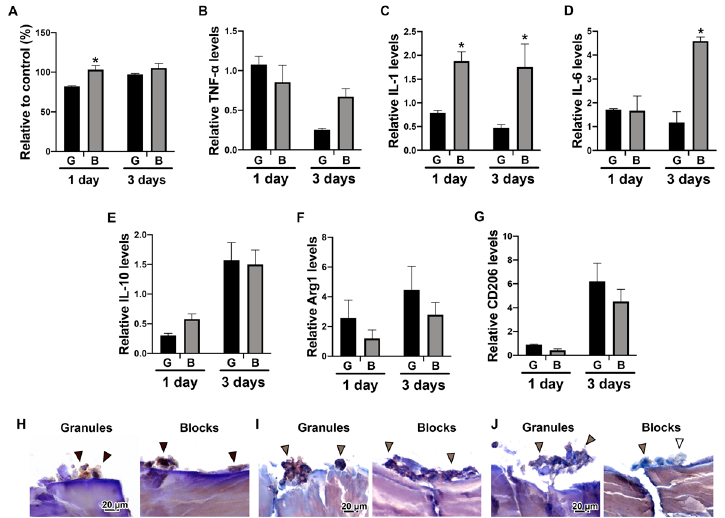
Figure 3. Macrophage polarization potential on DBBM granules or blocks. ( A ) Viability assay of THP-1-derived M ϕ s cultured on DBBM granules (shown as “G”) or blocks (shown as “B”) on days 1 and 3. (* Denotes significantly higher than the other group, p < 0.05). ( B – G ) Real-time PCR of M ϕ s seeded on DBBM granules or blocks for genes encoding ( B ) TNF- α , ( C ) IL-1, ( D ) IL-6, ( E ) IL-10, ( F ) Arg1, and ( G ) CD206 on days 1 and 3 after cell seeding. (* Denotes significantly higher than the other group, p < 0.05). ( H – J ) Immunochemical staining against ( H ) CD68, ( I ) CD86 and ( J ) CD206 on undecalcified frozen sections of M ϕ s cultured on DBBM granules or blocks for 3 days. (Original magnification 1000 ×).